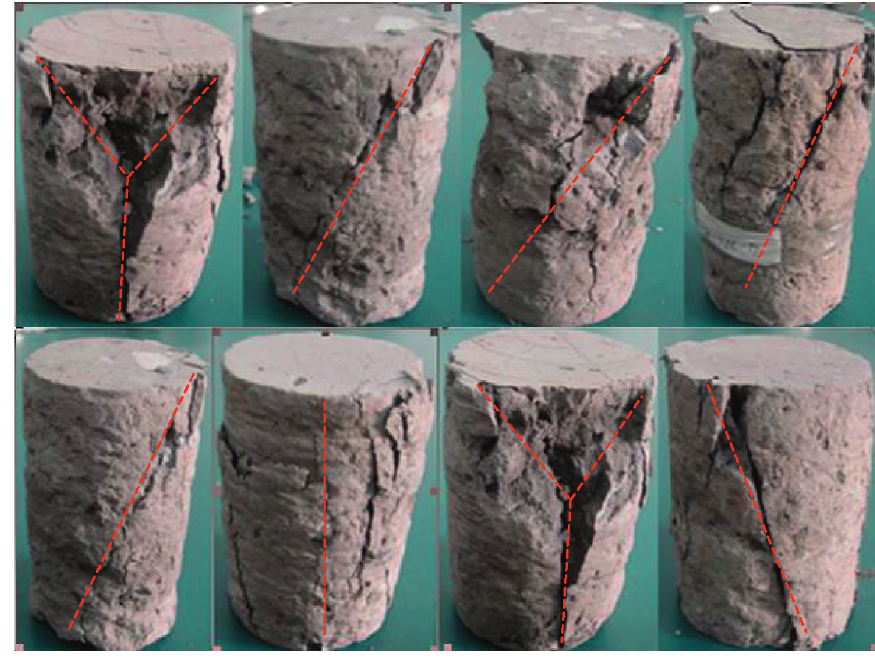
Figure 10: Photographs of damage in the compression samples.